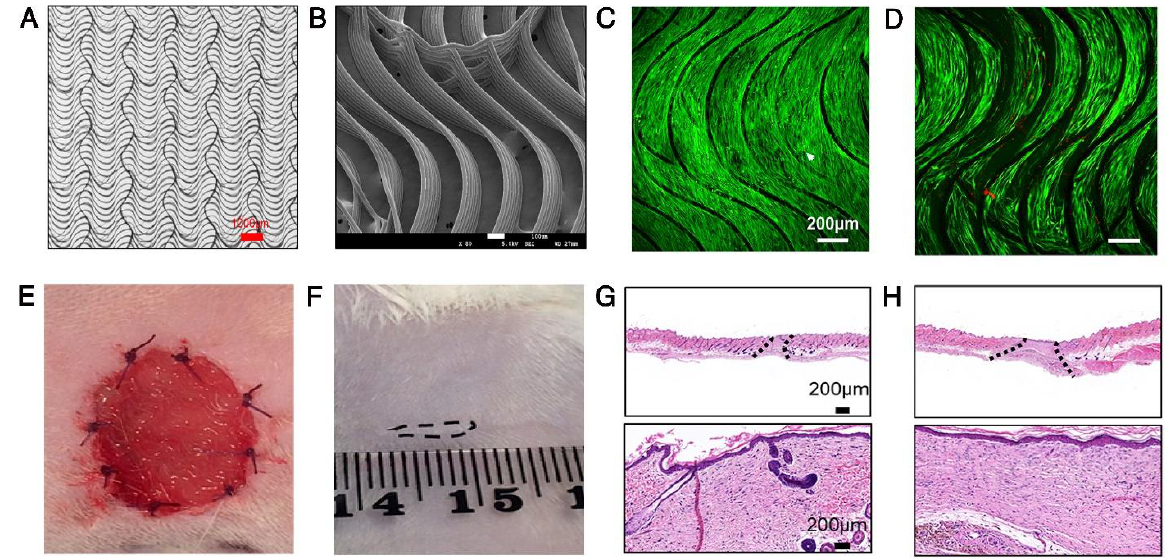
Figure 2. The proof-of-concept of the convergence of biomimetic matrices and stem/progenitor cell therapy. ( A ) Light microscopy and ( B ) scanning electron microscopy photographs show the microstructure of the anisotropic biomimetic medical-grade poly(caprolactone) (PCL) wound dressing. ( C , D ) The confocal laser scanning microscope images of fresh ( C ) and frozen ( D ) PCL wound dressings seeded with human gingival mesenchymal stem/stromal cells. Bioengineered constructs support the attachment, survival, and proliferation of cells. ( E ) The PCL wound dressings could adhere to the wound bed and be sutured to the surrounding tissues. The tissue-engineered PCL dressings were tested in an excisional wound in the rat model. After 6 weeks, the wounds are healed with reduced scarring ( F ) and complete epithelialization in fresh ( G ) and cryopreserved ( H ) tissue-engineered constructs. Adapted with permission from Elsevier, 2022 [125].